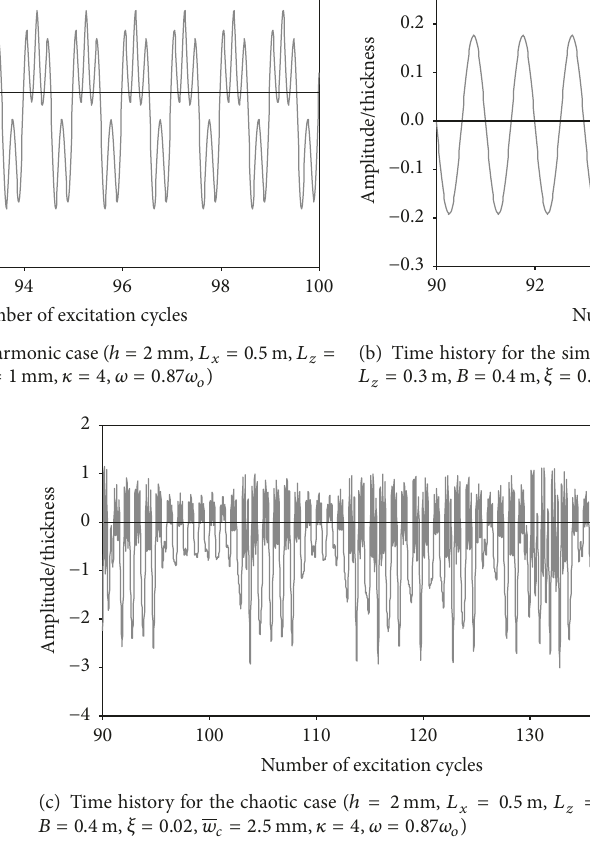
magnitude for various panel curvatures. Note that the positive and negative vibration amplitudes are not equal for curved panel. Generally, the vibration amplitudes are monotonically increasing with the excitation magnitude.